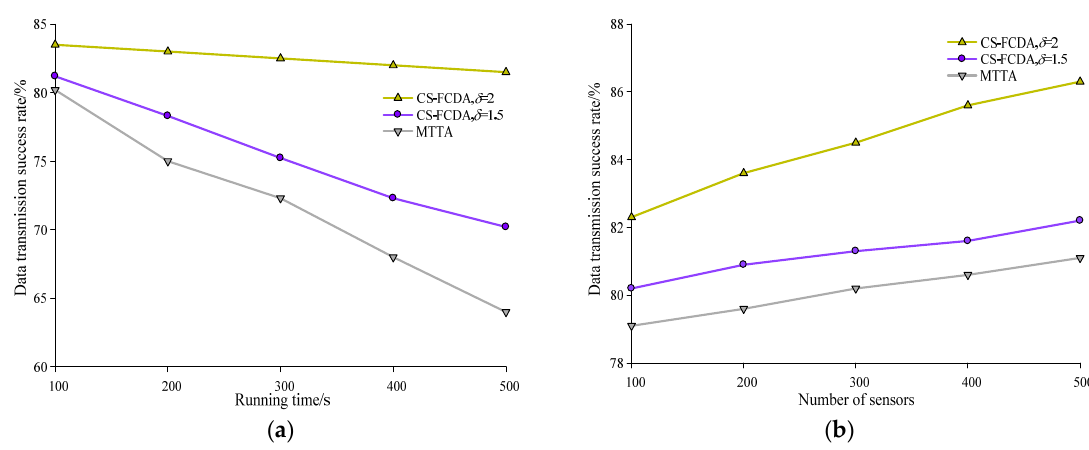
Figure 8. Success probability for data transmission. ( a ) Comparison between network running time and data transmission success rate. ( b ) Comparison between network number of sensors and data transmission success rate.